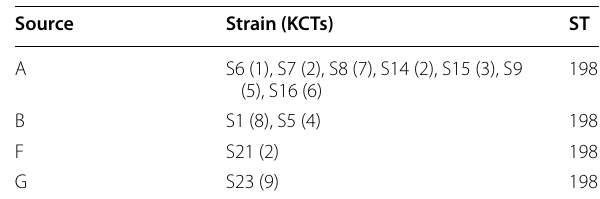
Table 3 Salmonella Kentucky strains used for molecular